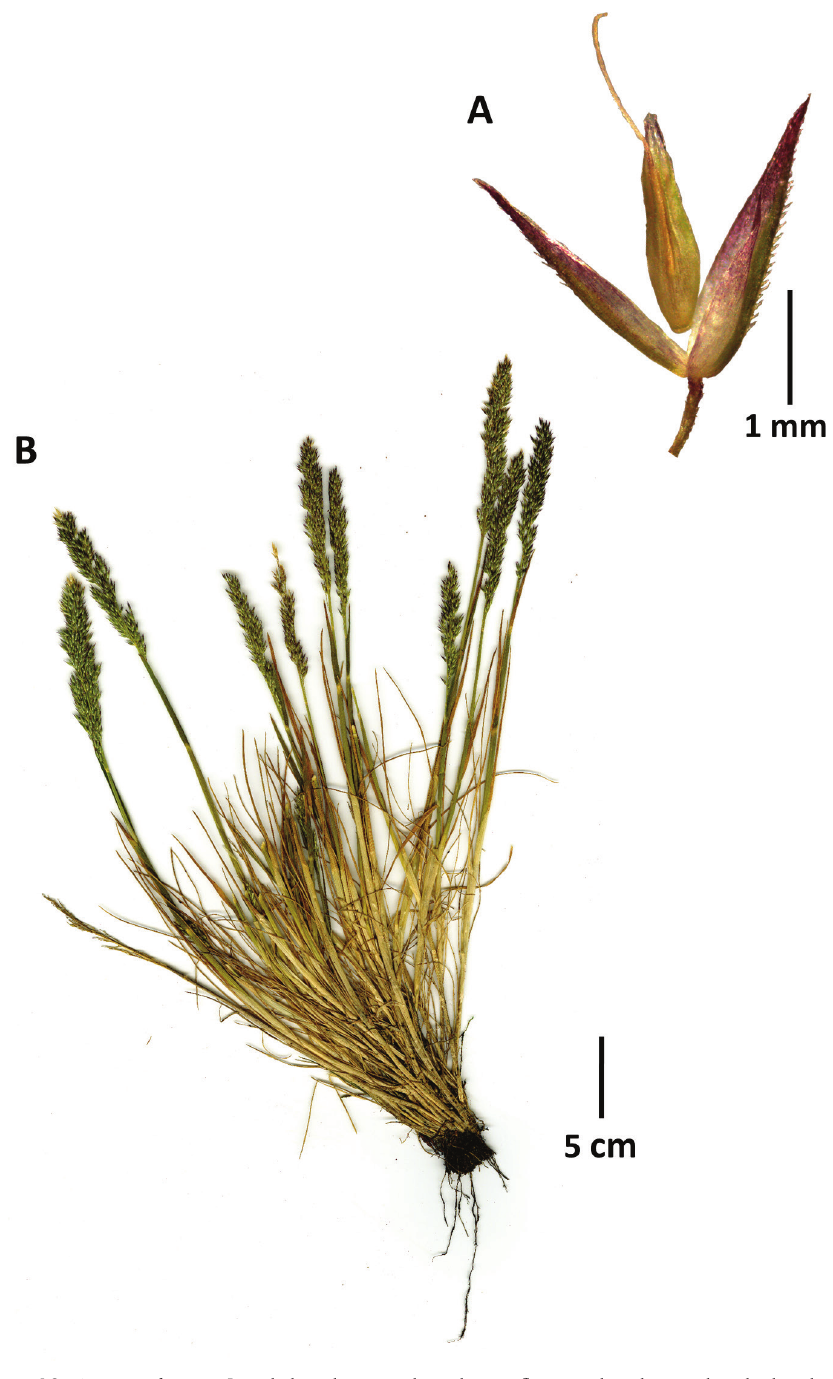
Figure 10. Agrostis tolucensis A spikelet, glumes in lateral view, floret in dorsal view, detached and raised above the glumes B whole plant. Images of Cuta-Alarcon 376